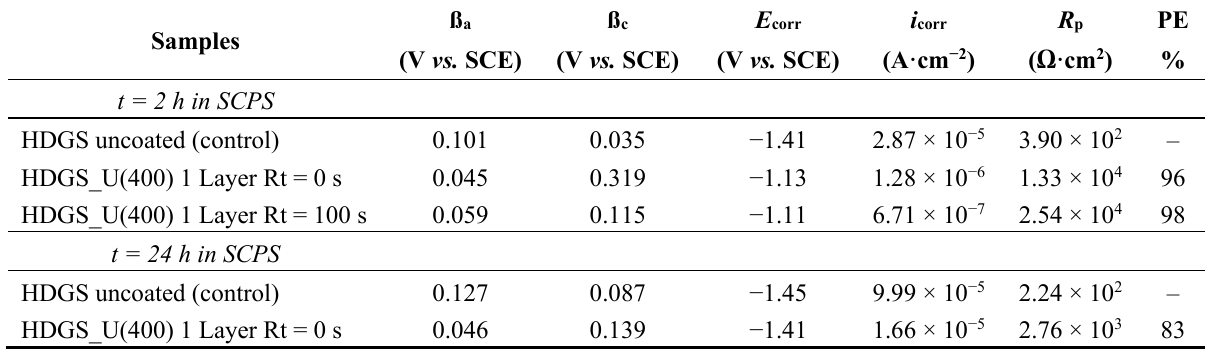
Table 5. Electrochemical parameters obtained from potentiodynamic polarization curves.